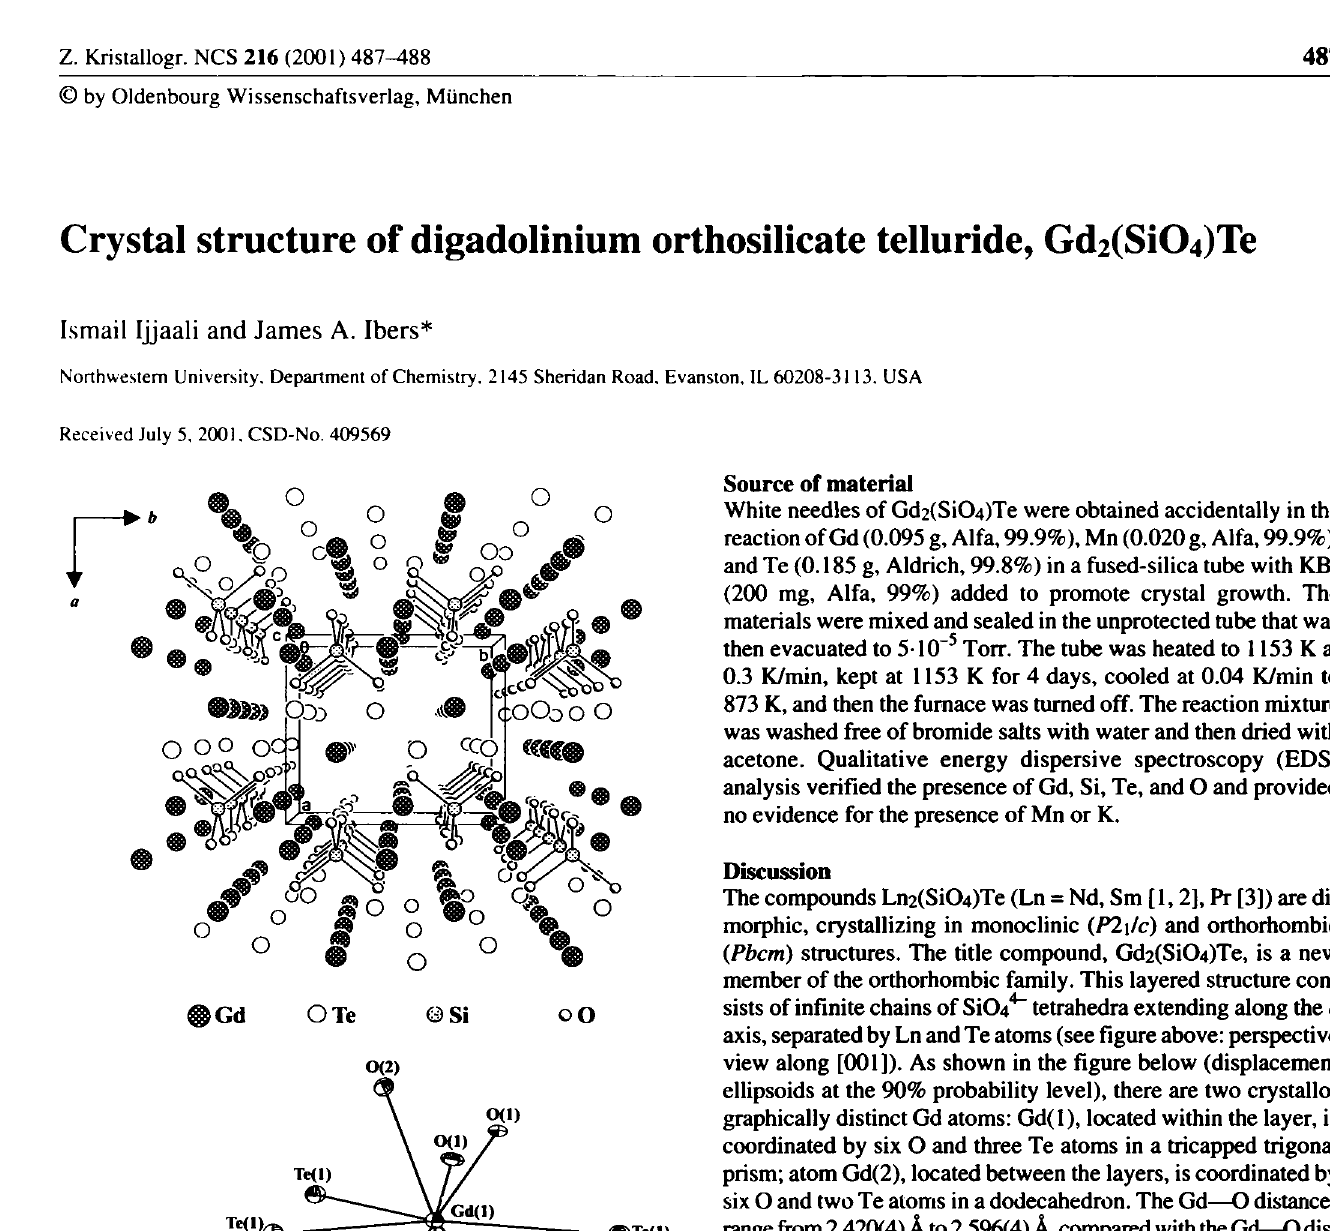
Table 1. Data collection and